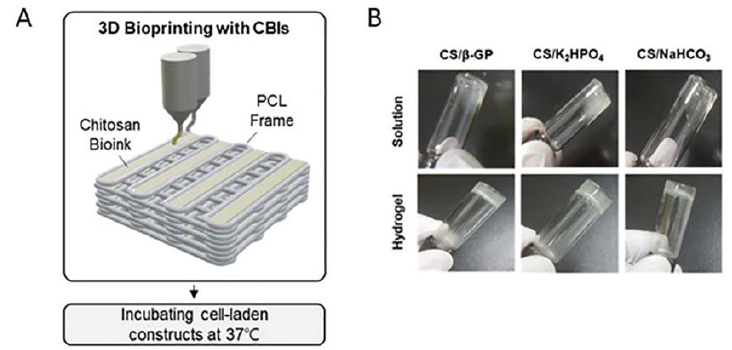
Figure 5. ( A ) Schematic representation of the 3D bioprinter for 3D printing and gelation using chitosan bioinks (CBIs). ( B ) Representative images of chitosan sol-gel transitions induced by temperature. Reprinted from [16].